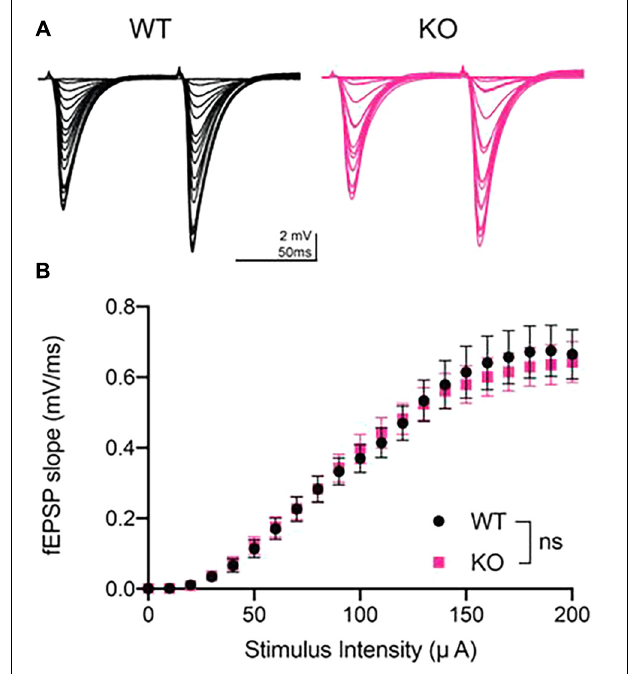
FIGURE 1 | Input/output curves showed no difference in basal synaptic strength at CA3-CA1 in PINK1 KO rats compared to WT littermate controls. (A) Representative fEPSP traces from 4 months WT (black) and PINK1 KO (Pink) rats. (B) After a stable 10 min baseline, input-output (I/O) curves were obtained by increasing the stimulus intensity (10 µ A increments) until a maximal fEPSP slope was obtained, usually at 200 µ A stimulus intensity. Initial slope of the ten fEPSPs generated at each stimulus intensity were averaged and plotted as a single value. No statistical difference ( p > 0.05) was found after using repeated measures two-way ANOVA [ F ( 1 , 50 ) = 0.01699] at the maximal stimulus intensity between WT ( n = 26 slices/11 animals) and PINK1 KO rats ( n = 26 slices/11